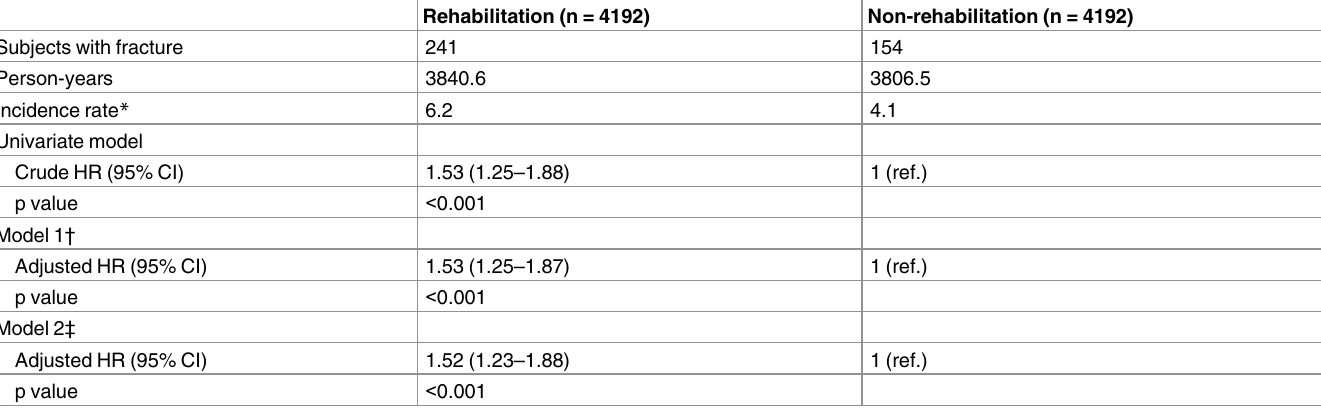
Table 2. Risk of fracture with or without post-stroke rehabilitation adjusted for covariates.